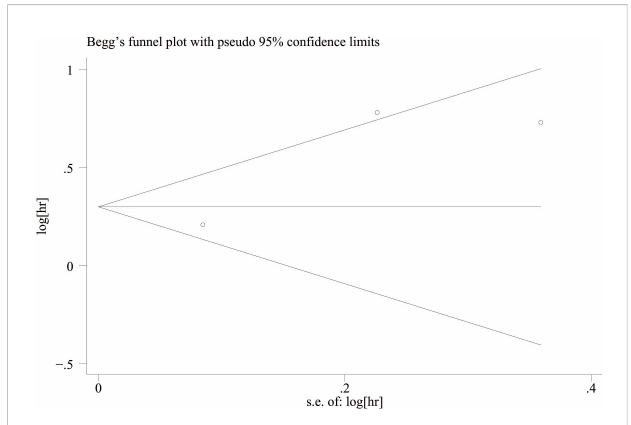
FIGURE 6 Funnel plot (categorized CRP and PFS in prostate cancer). CRP, C- reactive protein; PFS, progression-free